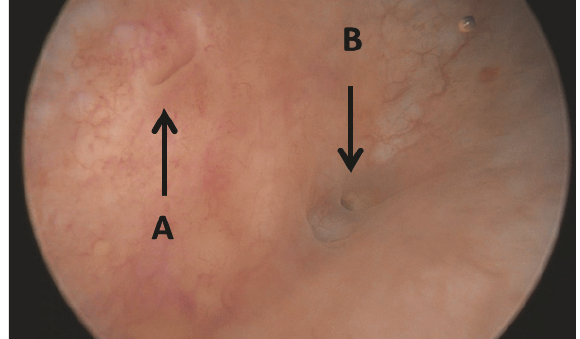
Figure 1: Cystoscopy performed before surgery. A: left ureteral meatus; B: fistulous orifice.